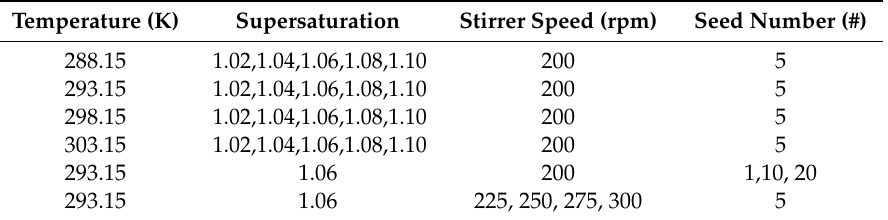
Table 1. Experimental conditions used in the seeding